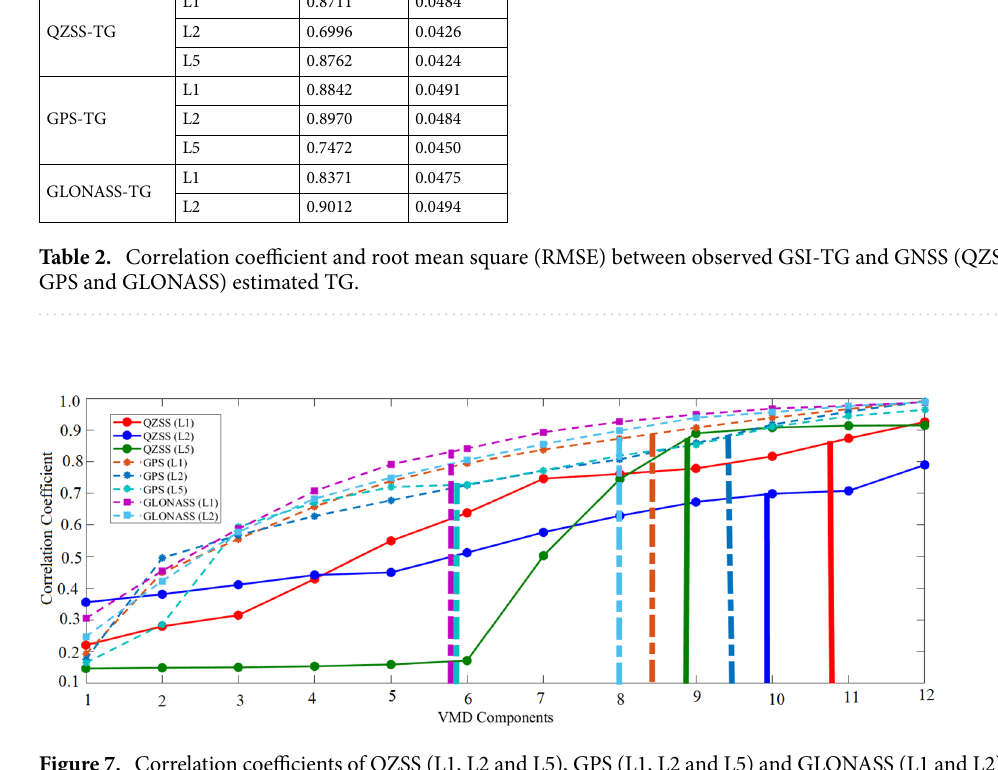
Figure 7. Correlation coefficients of QZSS (L1, L2 and L5), GPS (L1, L2 and L5) and GLONASS (L1 and L2) signals after implementing KELM modeling with 1–12 VMD